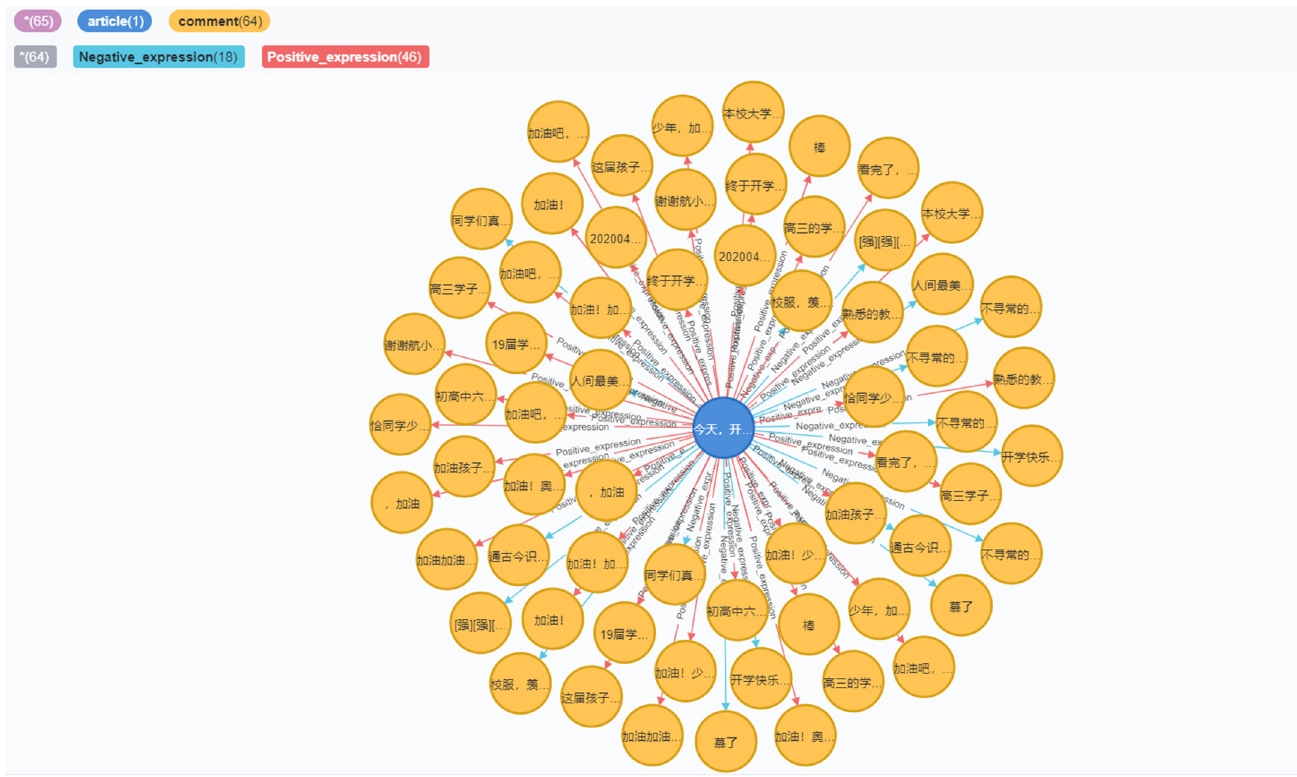
Figure 13. Query the results of the comments on the article “Today, school is starting! The first batch of Beihang back to school are they…”.